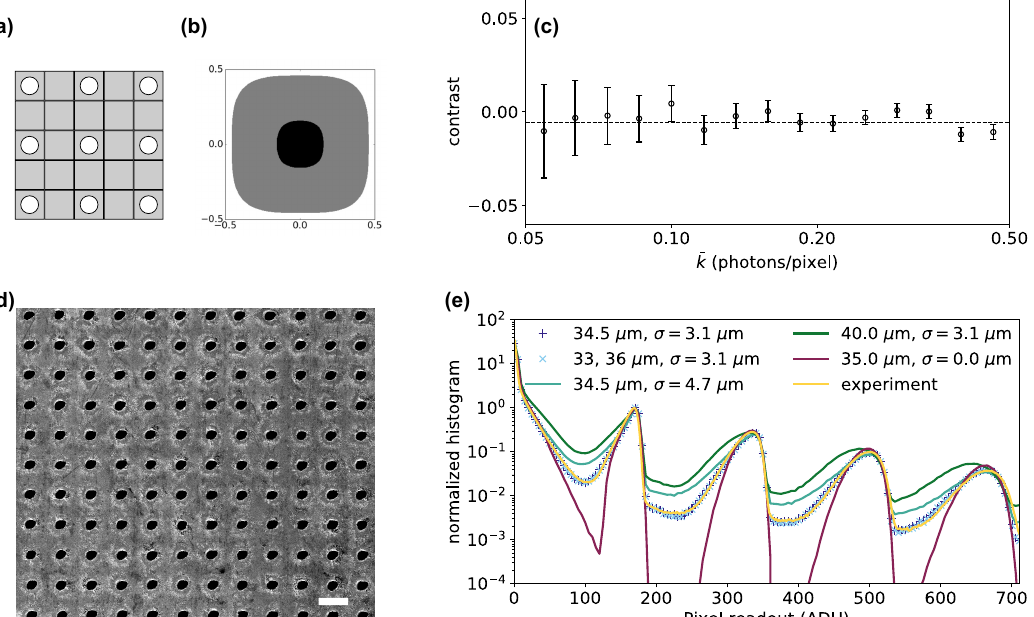
Figure 3. Detector mask to confirm unfocused beam as the zero-contrast calibration point. ( a ) Schematic of the detector mask with circular apertures that have a nominal diameter of 35 µ m aligned to every other pixel of the epix100 detector. ( b ) Regions within a single pixel that have different single-photon contribution fractions assuming a Gaussian charge cloud with a size of 0.385 pixel (FWHM), which reproduces the pixel histogram of the ePix100 detectors. The black area denotes the region where a photon will contribute 98% of its generated charges to the readout of this pixel. The gray area denotes the region for more than 60% of the charges to be collected by this pixel. ( c ) Extracted contrast from the scattering of unfocused beam with the mask aligned with the detector. ( d ) Scanning electron microscope measurement of the mask (scale bar: 100 µ m). ( e ) Simulated and measured pixel histograms of the detector with different parameters of the mask. Here, σ is the standard deviation of the Gaussian distributed position error of individual